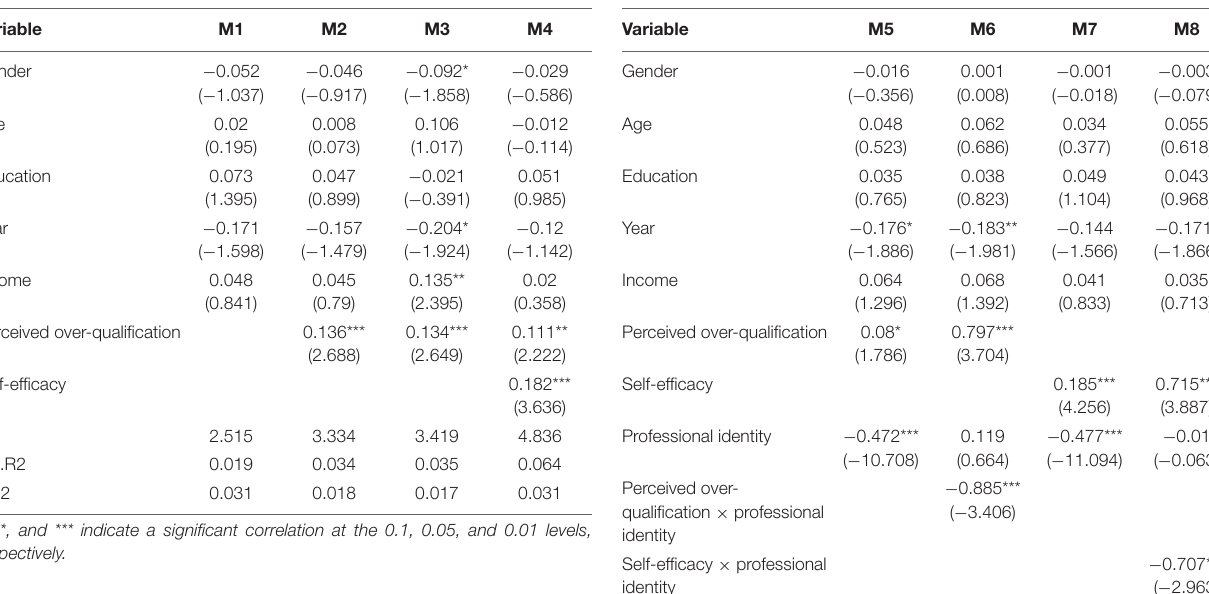
TABLE 6 | Results for the main effect and mediating role. TABLE 7 | Results for the moderation